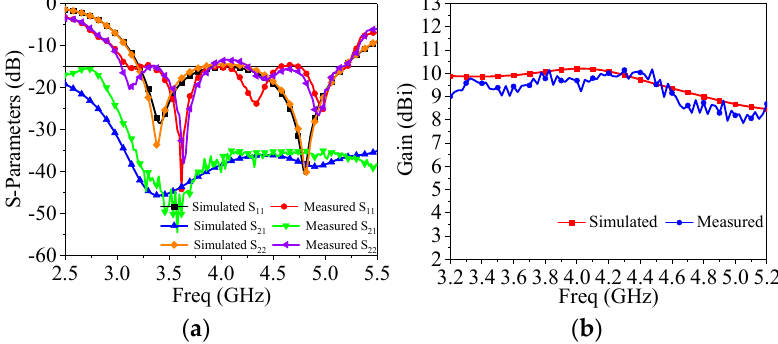
Figure 10. The simulated, measured S-parameters and gain. ( a ) S-parameters, ( b ) gain.